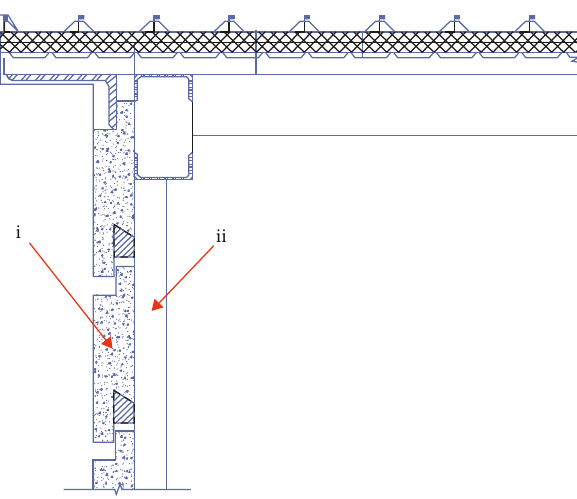
Figure 7: Connection between (i) prefabricated hanger slab and (ii) prefabricated hanger column.